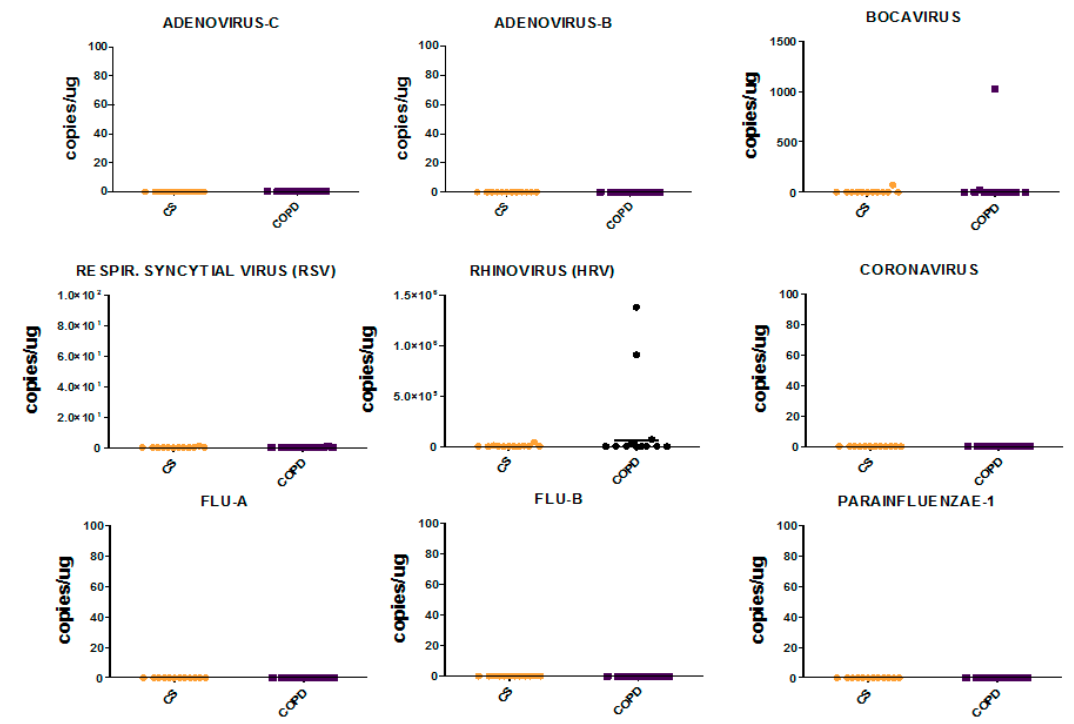
Figure 2. Viral load individual values in bronchial rings of control smokers (CS) and COPD patients quantified by RT-PCR. Horizontal bars are median values. Data are reported as copies/µg of bronchial ring tissue examined for Adenovirus-C, Adenovirus-B, Bocavirus, Respiratory Syncytial Virus (RSV), Rhinovirus (HRV), Coronavirus, Flu-A, Flu-B and Parainfluenzae-1. Results are representative of those from 12 subjects with stable COPD and 12 control smokers with normal lung function. The Mann-Whitney U test for statistical analysis was non-significant ( p > 0.05) for all the viruses studied.